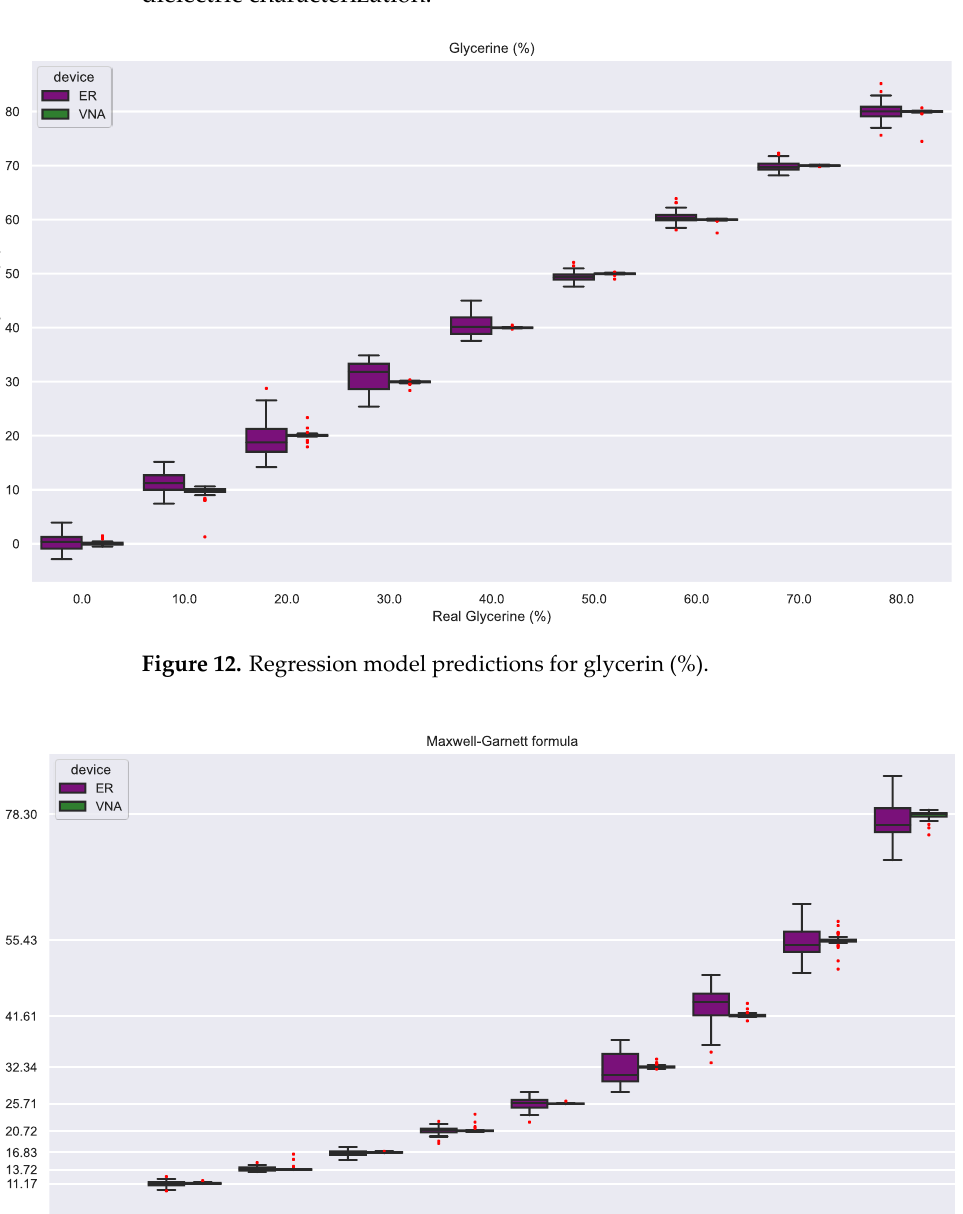
Figure 13. Permittivity estimations for both devices from an SVR model trained with the permittivity values from the Maxwell–Garnett mixing rule.